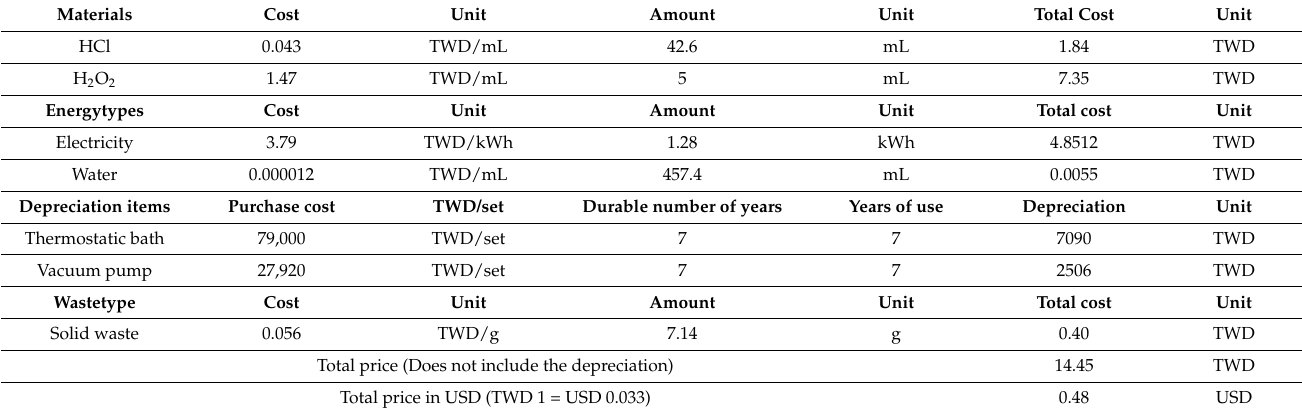
Table 8. Hydrochloric acid leaching cost.